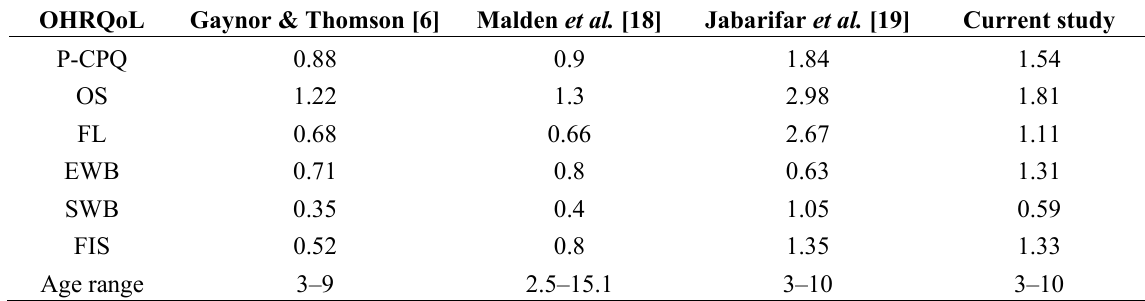
Table 5. Comparison of effect sizes from three previous studies to the current study. OHRQoL Gaynor & Thomson [6] Malden et al.